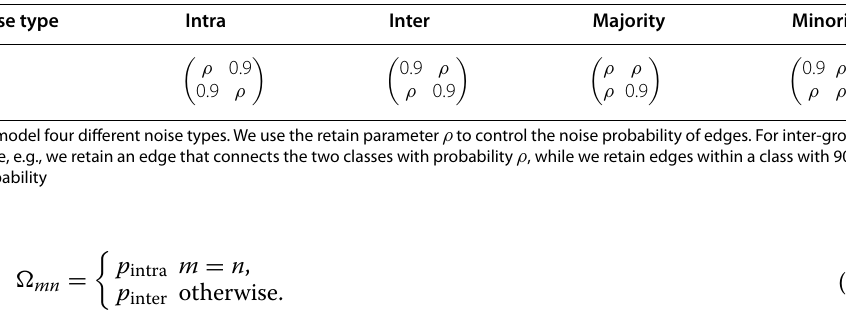
Table 1 Specific parametrization of label-based error matrix (cid:31) used for numerical experiments Noise type Intra Inter Majority Minority